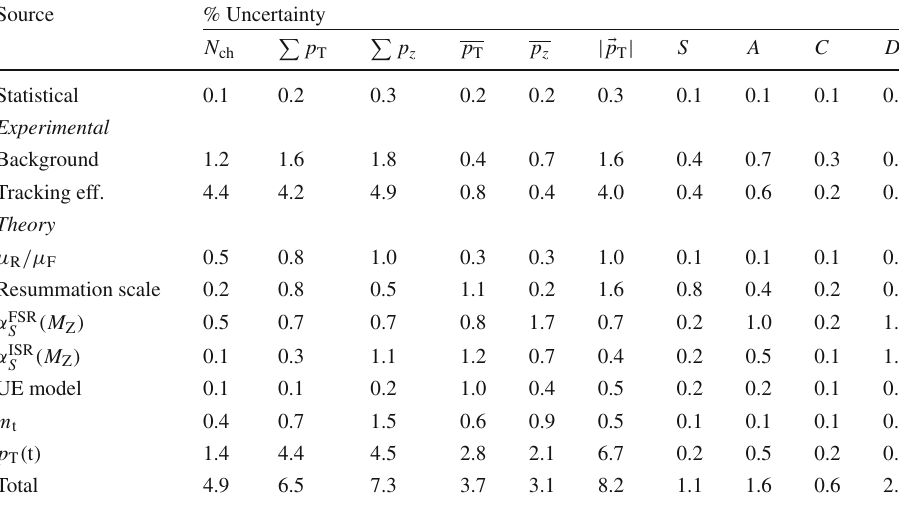
Table 2 Uncertainties affecting the measurement of the average of the UE observables. The values are expressed in % and the last row reports the quadratic sum of the individual contributions